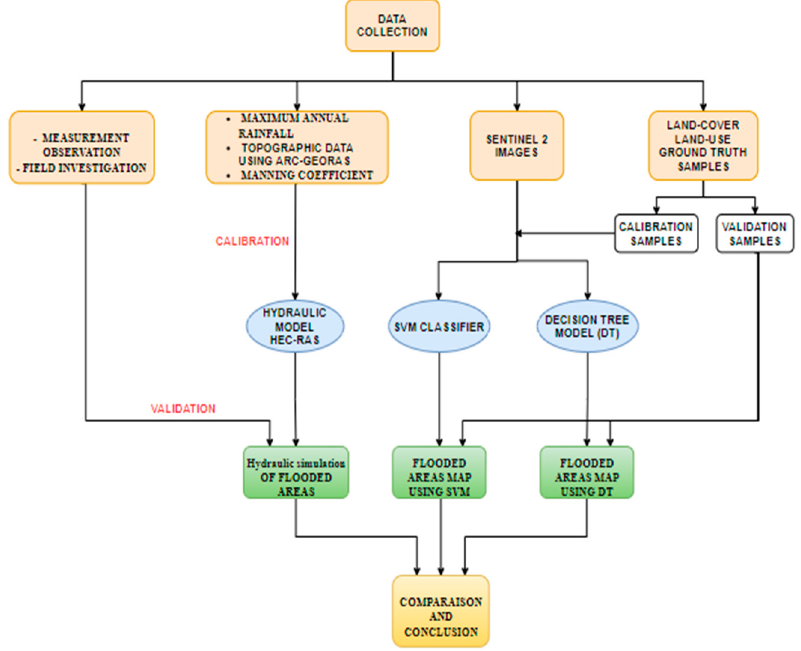
Figure 5. Flowchart for the different steps of the methodological approach for flash-flooded area mapping.